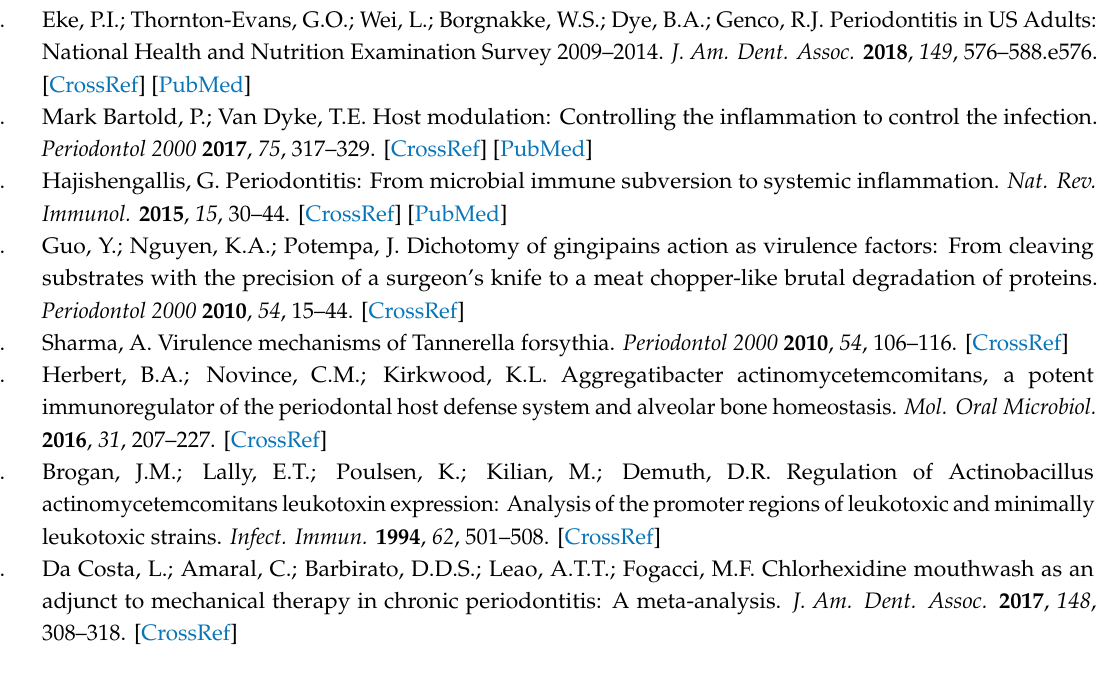
Table S1: Minimal inhibitory concentration (MIC) of taurolidine (% w / v ) determined at baseline and after certain passages on agar plates containing subinhibitory concentrations of the compound; Table S2: Minimal inhibitory concentration (MIC) of minocycline ( µ g / mL) at baseline and after certain passages on agar plates containing subinhibitory concentrations of the compound; Table S3: Strains included in the